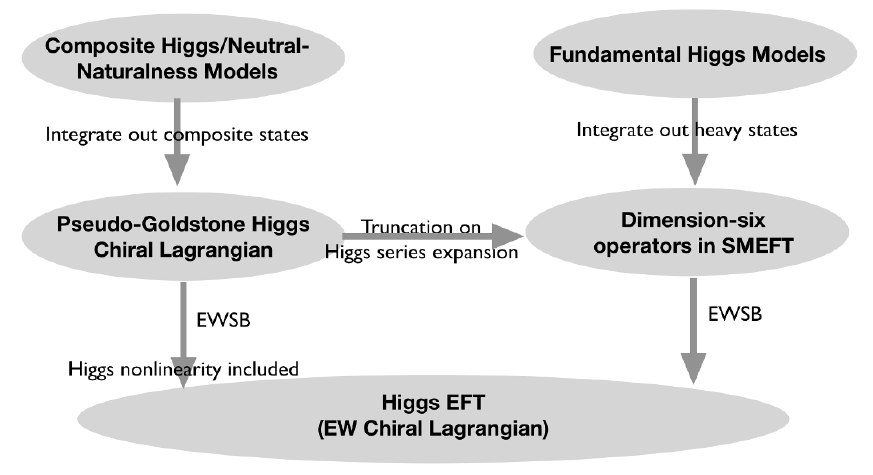
Figure 1 . Illustration of the relations between di(cid:11)erent